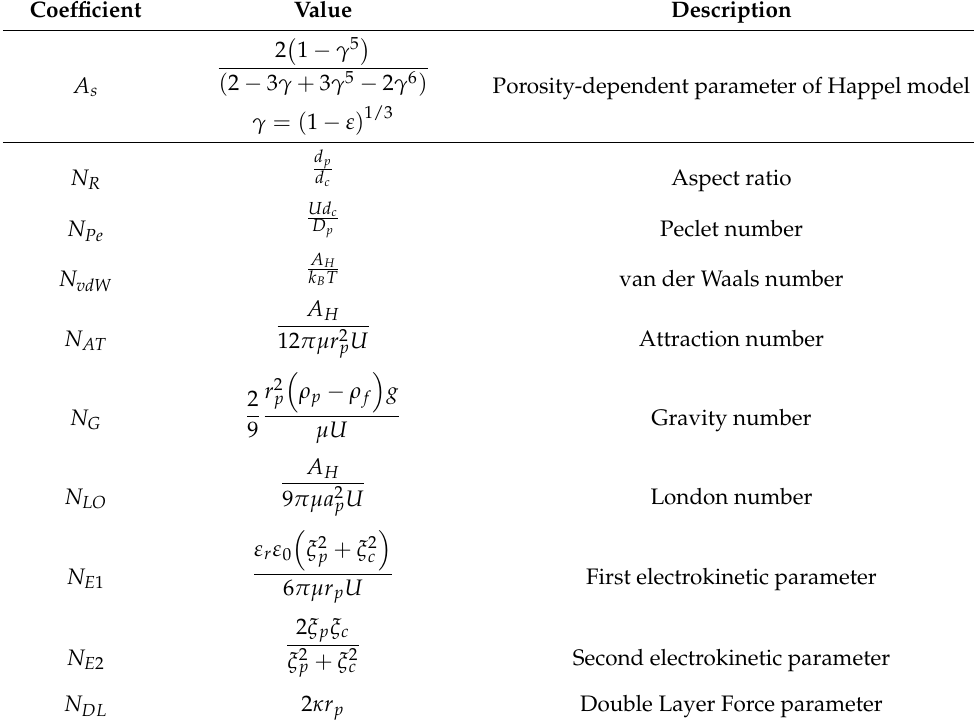
Table 1. Definitions of non-dimensional coefficients used in correlation equations. All symbols are defined in Table